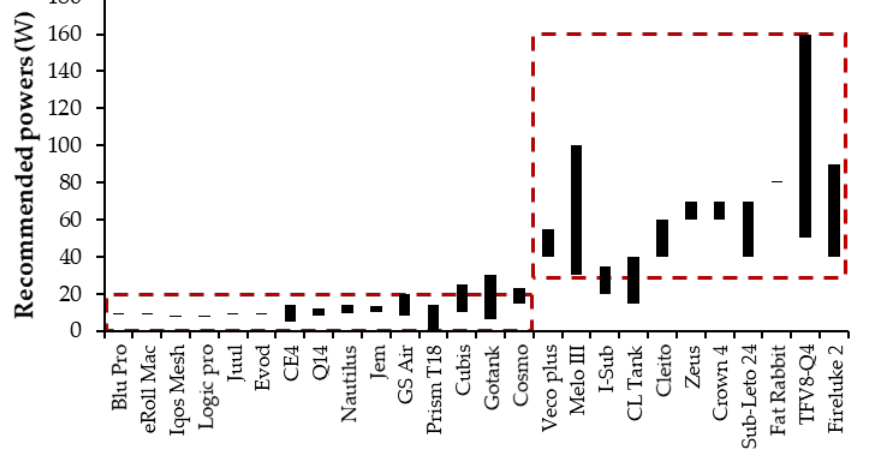
Figure 8. Recommended powers of the twenty-six tested devices.